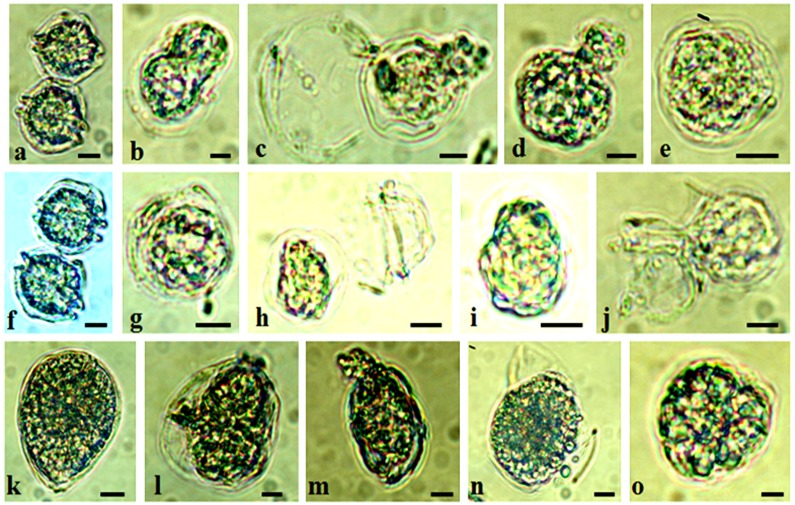
Light microscope observations of morphological damages of vegetative cells of the targeted dinoflagellate species.Photographs of Alexandrium pacificum cells cultured with Cymodocea nodosa (a-e) and Ulva rigida (f-j); and of Ostreopsis cf. ovata cultured with Ulva rigida (k-o). a,f,k = control cells; b-e, g-j, l-o = cells under increasing macrophyte weights. Scale bars, 10 μm.